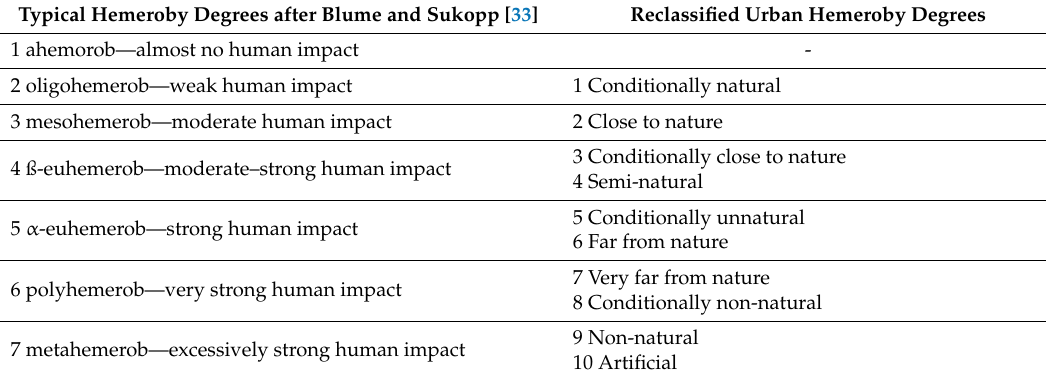
Table 1. Hemeroby degrees according to Jalas (1955) and Blume and Sukopp (1976) [20,33] and